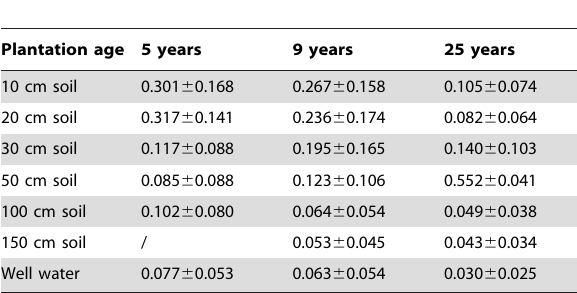
Table 1. Water use ratio (mean 6 SD) of different source for three ages of Caragana intermedia plantations.